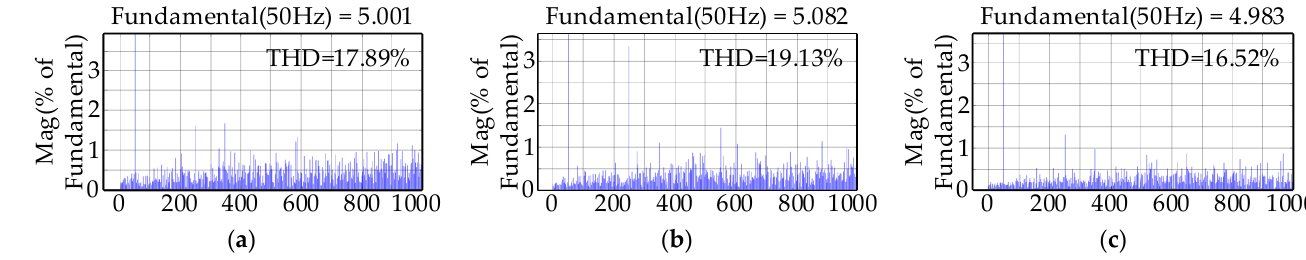
Figure 7. Phase current Fourier analysis of three control strategies under matched motor parameters: ( a ) MPCC; ( b ) CMFPCC; ( c ) IMFPCC.